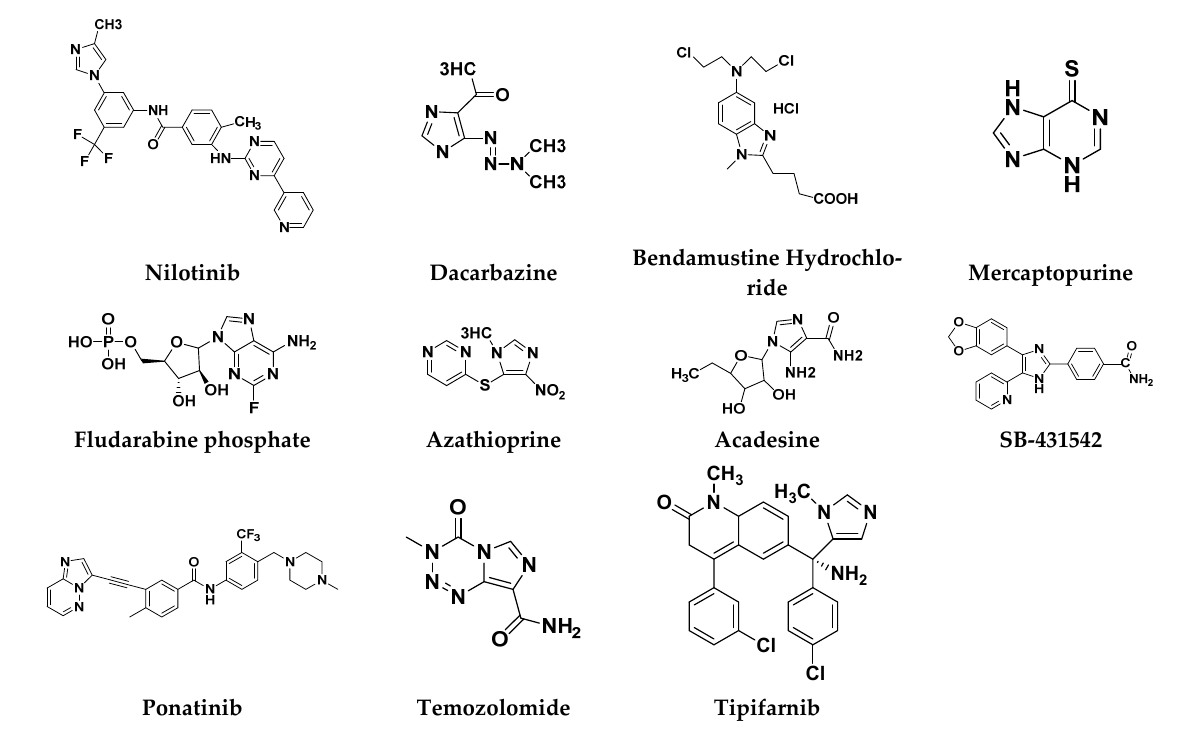
Figure 55. Imidazole based anticancer drugs that are FDA approved or in clinical trials. Table 42. Imidazole based anticancer drugs with brand/company name, specific cancer types and